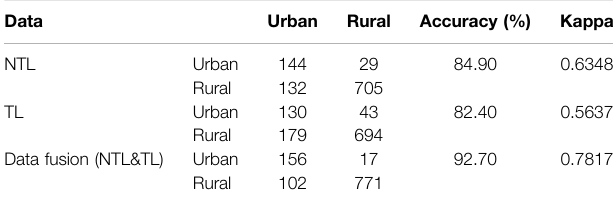
TABLE 1 | Accuracy veri fi cation of urban agglomeration boundary delineation